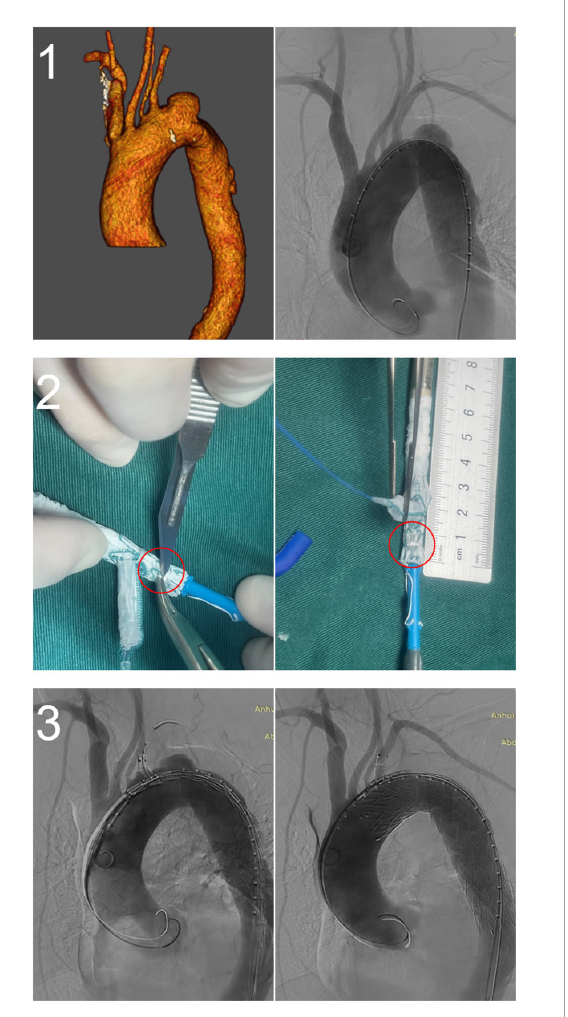
FIGURE4 A fenestrated-branched stent graft was used to reconstruct the left subclavian artery (LSA) and the left vertebral artery (LVA). (1) Preoperative computed tomography angiography showing that the LVA originated from the aortic arch. (2) In vitro fenestration of the Castor stent graft. (3) Intraoperative and postoperative angiography showing the successful reconstruction of the LSA and